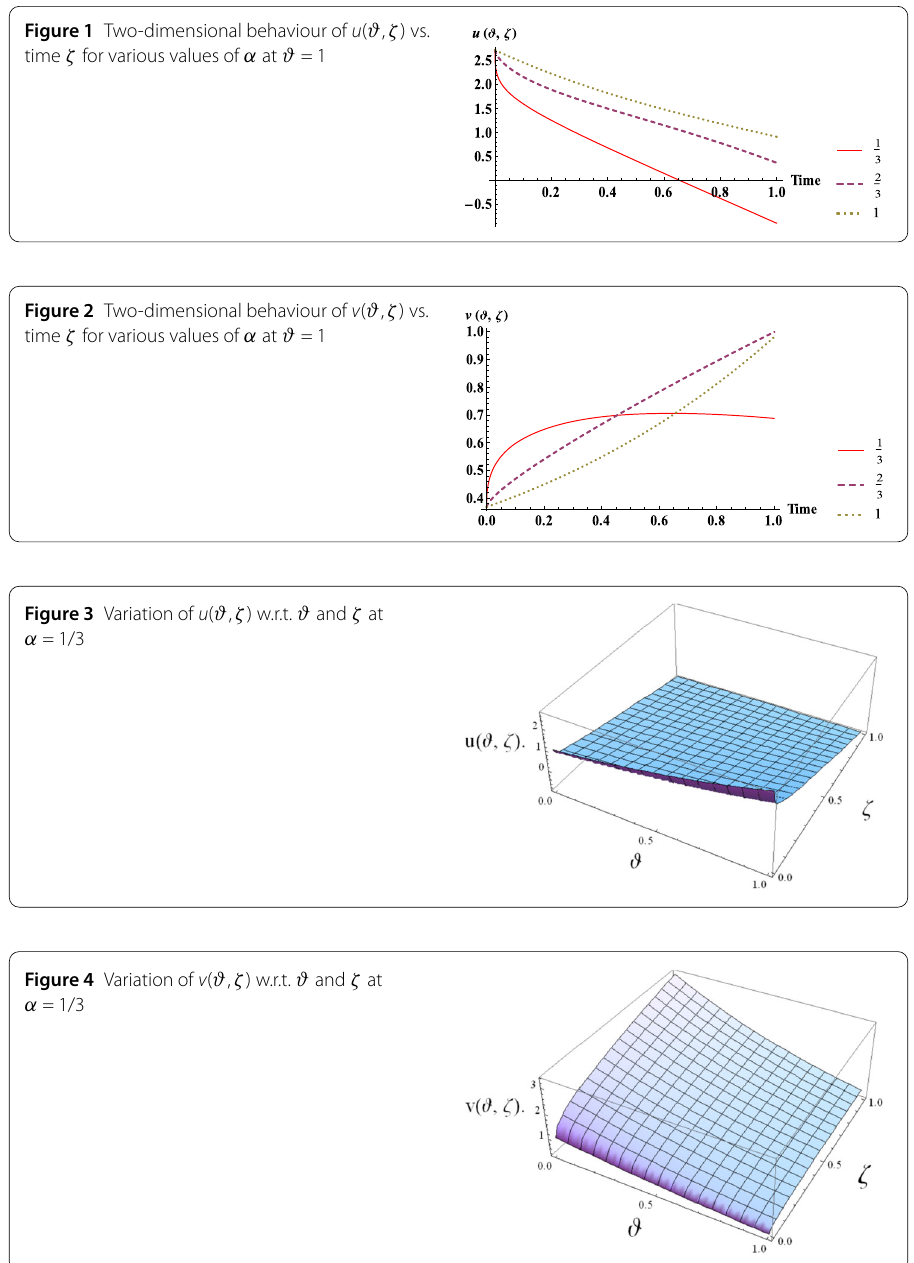
Figure 1 Two-dimensional behaviour of u ( ϑ , ζ ) vs. time ζ for various values of α at ϑ = 1